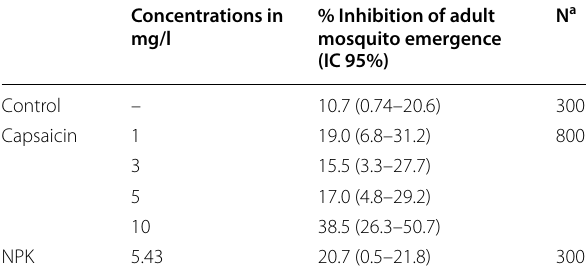
capsaicin and azadirachtin +